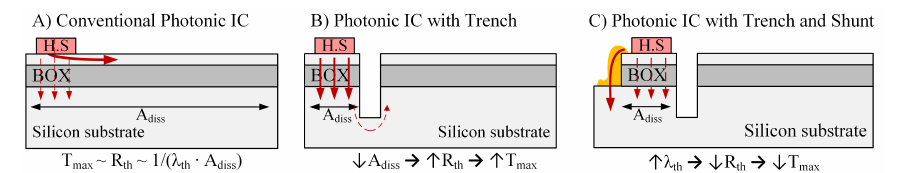
Figure 1. Schematic representation of a conventional photonic integrated circuit (IC) and of the proposed concepts. The red arrows represent the direction of heat flow. ( A ) Conventional PIC with an integrated heat source. ( B ) Photonic IC with trench for separation of the chip in two independent thermal regions. ( C ) Trenched chip with heat shunt to create a high thermal conductivity path between the heat source and the silicon substrate, reducing the thermal resistance of the